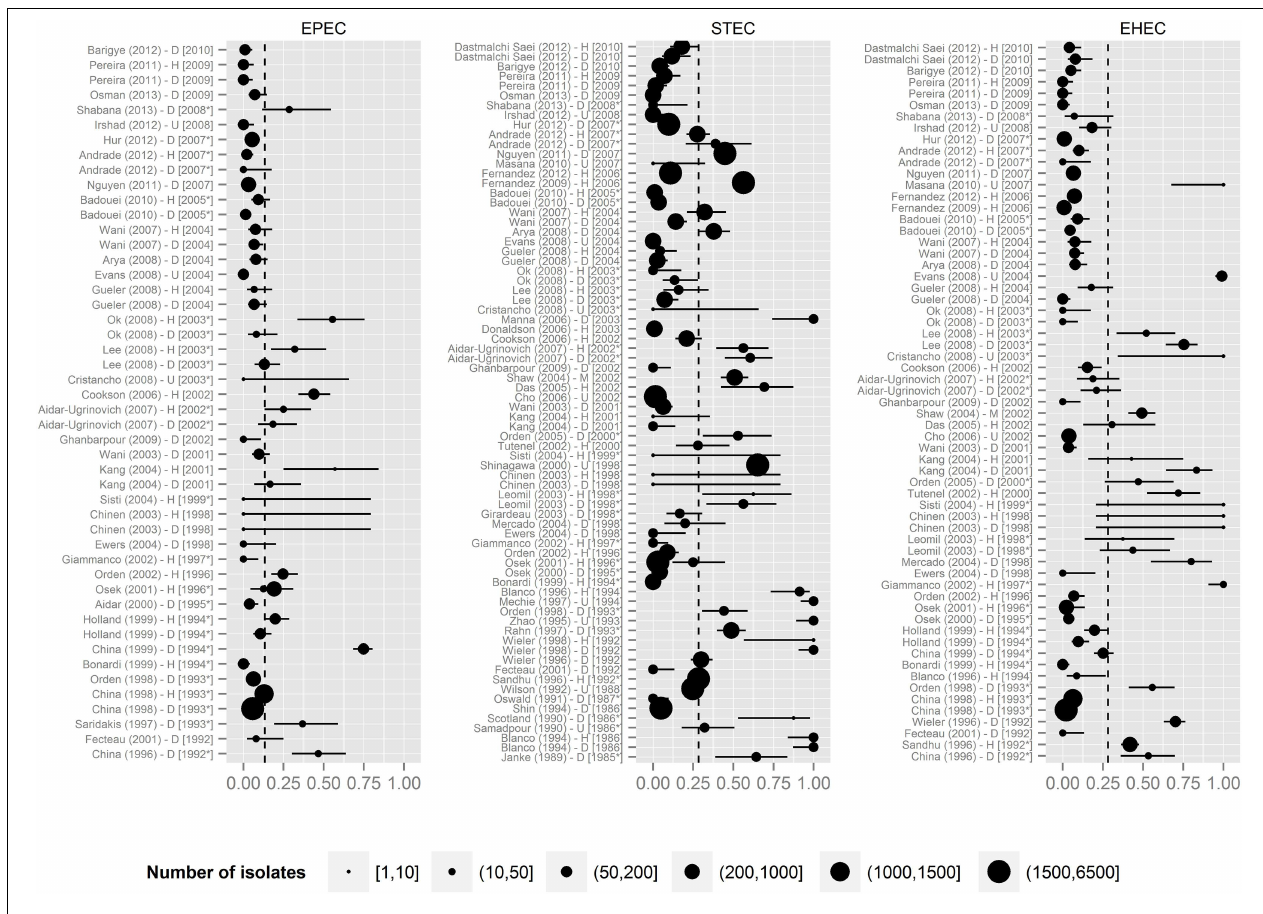
FIGURE 4 | Prevalence of STEC, EPEC, EHEC in the manuscripts under review. The dashed vertical lines represent the mean prevalence of the given pathotype of all studies. Labels contain information about the first author of the study, the year of publication, the health status of animals (H,